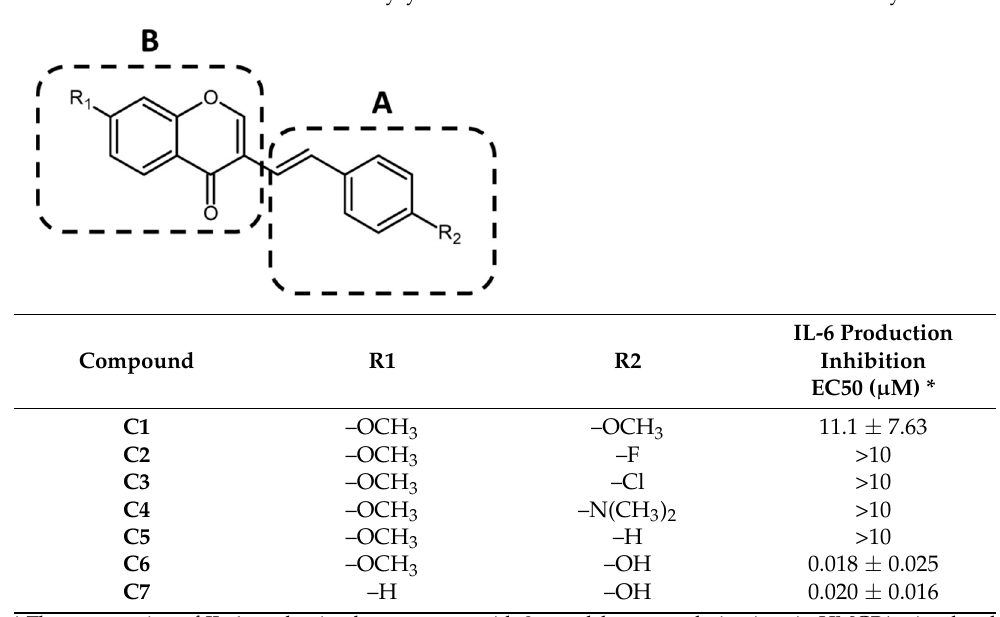
Table 1. General structural units of 3-styrylchromone derivatives and their anti-inflammatory activities.